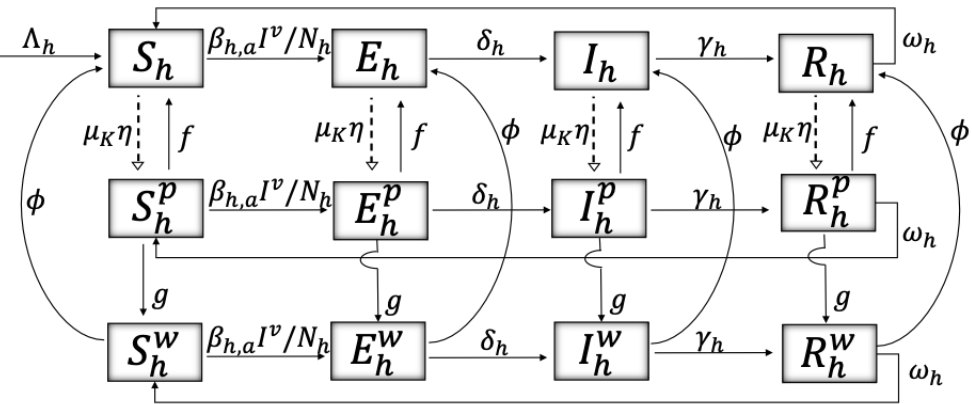
Figure 1. I v = I v + I r v . Schematics showing the flow between malaria disease states: Susceptible ( S x ), exposed ( E x ), infectious ( I x ), and recovered ( R x ); the flow between intoxication levels due to h h h h insecticide exposure, where the superscript x ∈ {{} , p , w } represents poison states in humans: no toxicity, acute intoxication, and toxicity with possible health effects (chronic intoxication), respectively. The dashed lines represent discrete moments in time when individuals are exposed to the toxicity, and the solid lines represent continuous rates. A description of the variables and parameters used can be found in Tables 1 and 2,